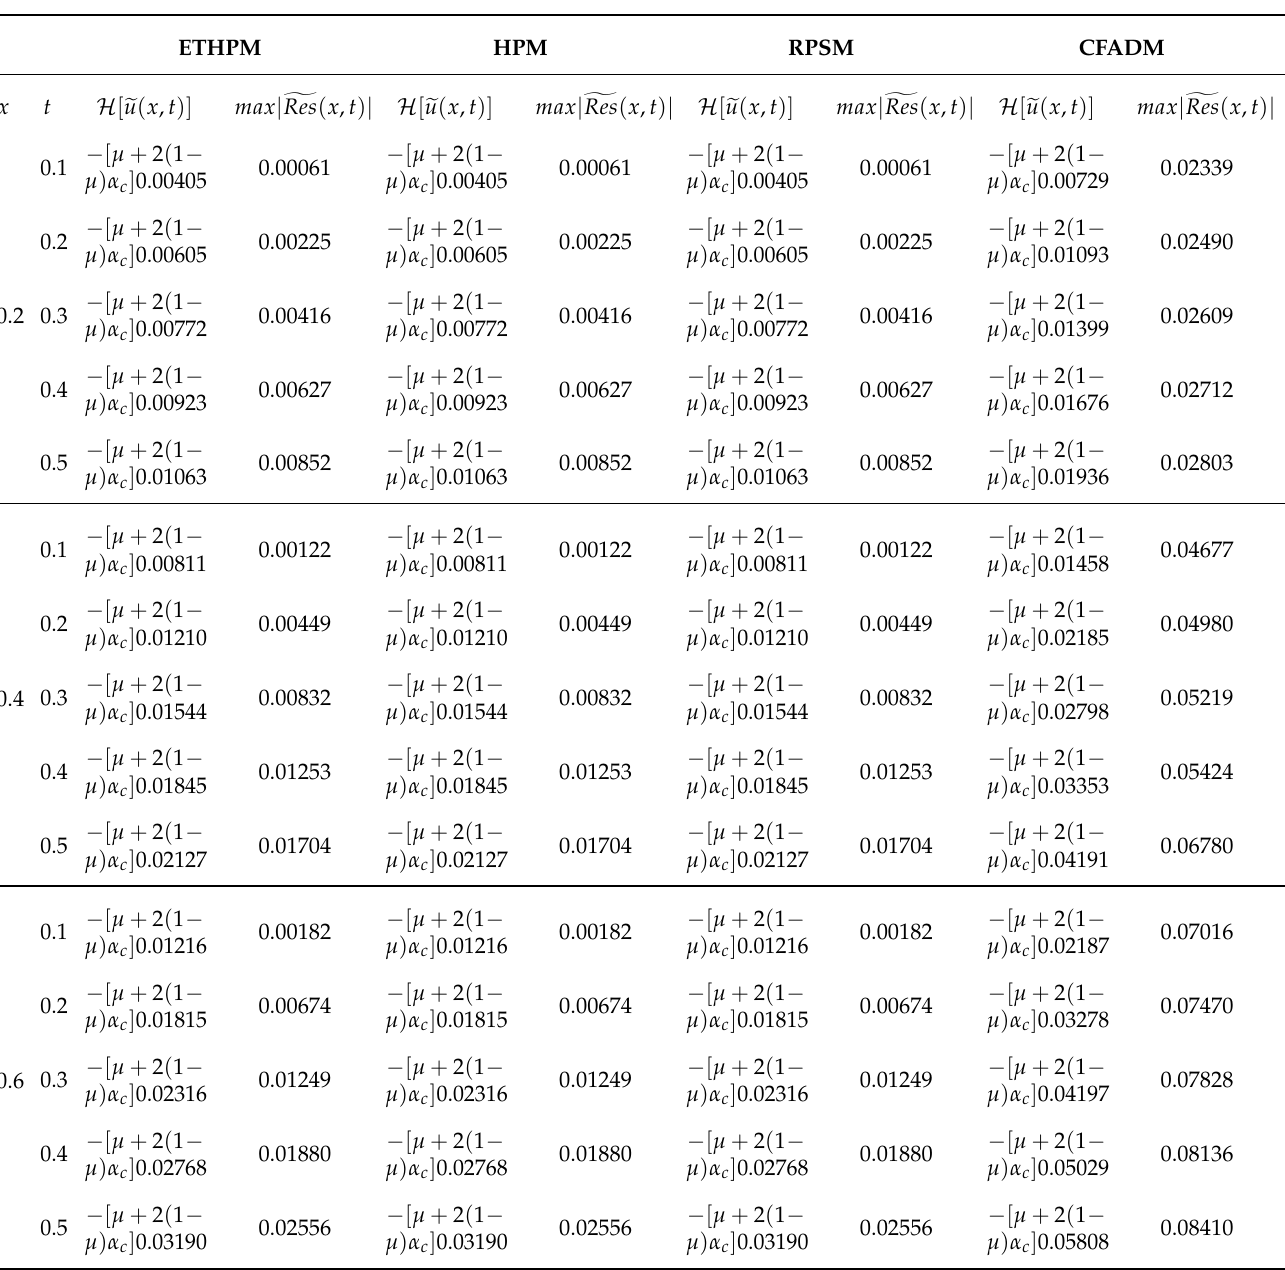
Table 7. H [ (cid:101) u ( x , t )] and max | (cid:103) Res ( x , t ) | by ETHPM, HPM, RPSM, CFADM for α = 0.5, τ = 0.2, r = 0.25, A = 1, B = 10.